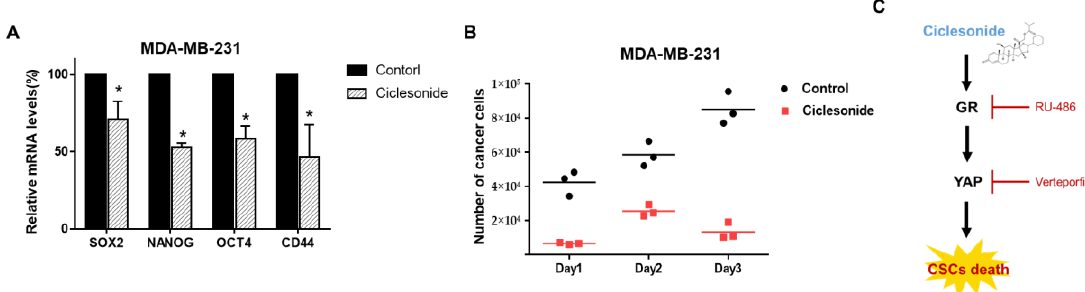
Figure 6. The effect of the antiasthma medication ciclesonide on CSC levels in breast cancers. ( A ) The mRNA levels of Sox2, Nanog, Oct4, and CD44 were assessed in ciclesonide-treated mammospheres using specific primers. β-actin was used as the loading control. * p < 0.05 vs. the control. Experiments were repeated three times. ( B ) Ciclesonide (10 μM) inhibited mammosphere growth. Ciclesonide-treated mammospheres were dissociated into single cells, and equal numbers of cells were cultured in 6 mm dishes. One day after plating, the cells were counted. After two and three days, the cells were counted in triplicate, and the mean value was plotted. ( C ) The proposed schematic suggests that ciclesonide induced GR degradation, YAP downregulation, and CSCs inhibition. GR and YAP activity contributes to CSC formation and inhibition of GR and YAP expression via siRNA suppresses CSCs formation.